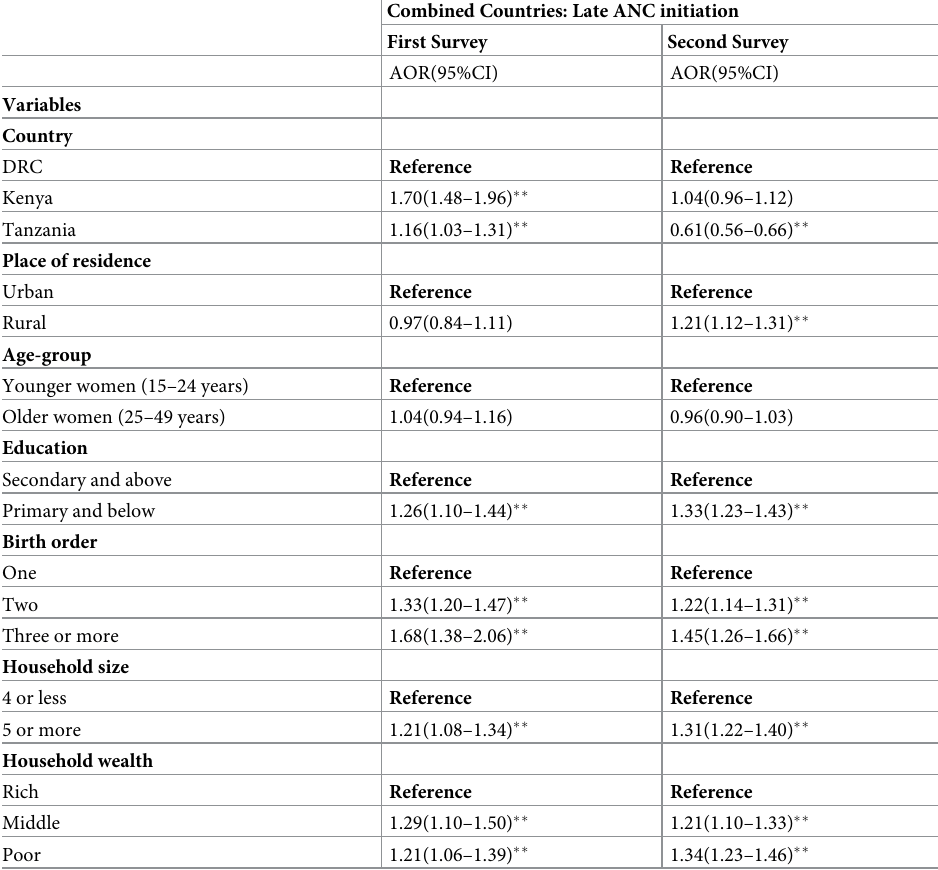
Table 3. Determinants of late ANC initiation in the combined